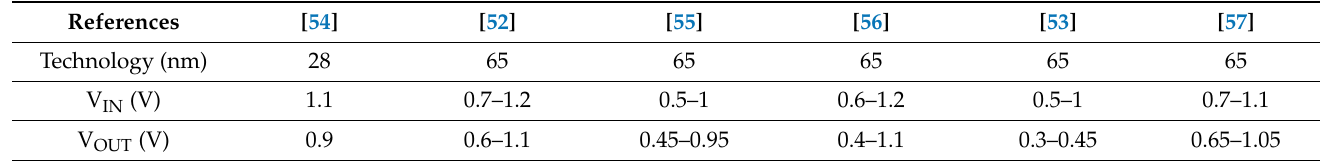
Table 2. Summary of the DLDO performance